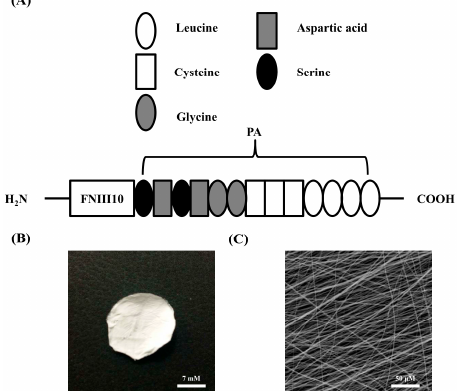
Figure 1. Structure of fibronectin type 10-peptide amphiphile (FNIII10-PA) ( A ) and morphology of polycaprolactone(PCL) fiber ( B , C ). Peptide amphiphile (PA) sequence, LLLLCCCGGDS (L, leucine; C, cysteine; G, glycine; D, aspartic acid; S, serine) was connected with fibronectin type III10. Scale is 7 mM in panel B, 50 µ M in panel C (resolution 500 ×